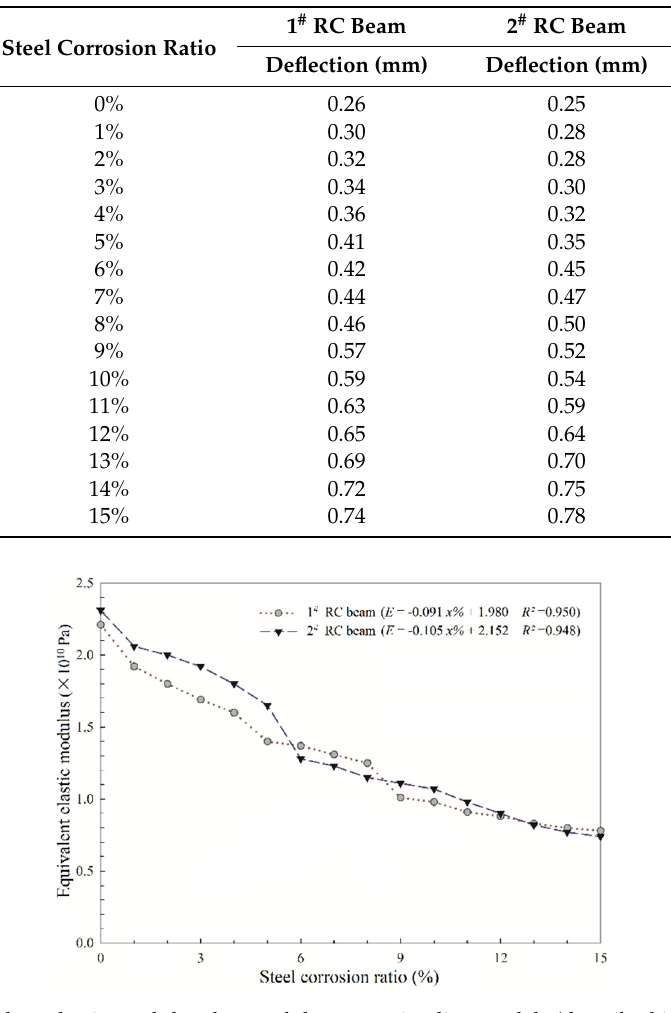
Figure 10. Equivalent elastic modulus data and the regression line models (described in the legends) of the two RC beams affected by the steel corrosion ratio.